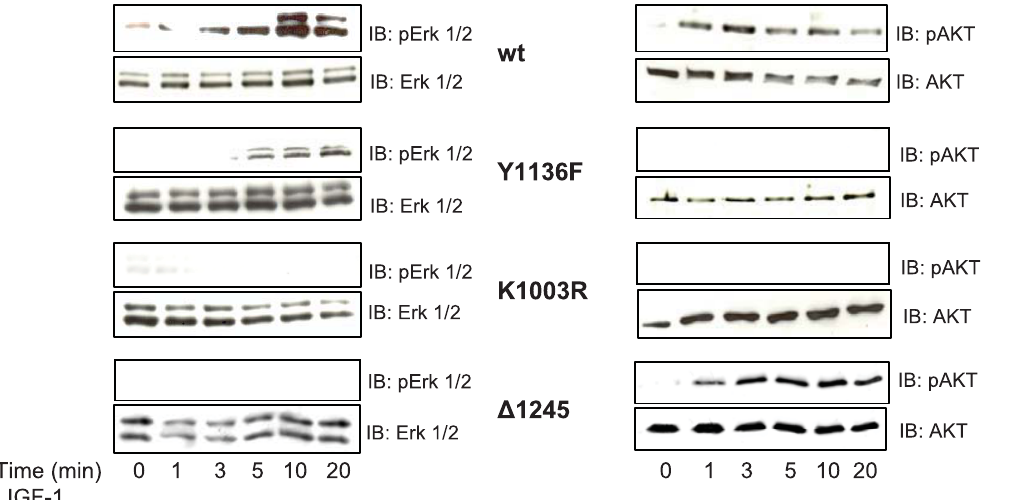
Figure 4. Ubiquitination of IGF-1R is crucial for ERK signaling. After 24 h serum starvation wt, Y1136F, K1003R, and D 1245 cells were stimulated with IGF-1 for the indicated times and lyzed. The lysates were resolved by SDS-PAGE and analyzed by western blotting with anti-phospho-Akt, anti- phospho-ERK. The blots were then stripped and reprobed with anti-Akt, anti-Erk antibodies to demonstrate equal loading. The experiments were repeated with similar